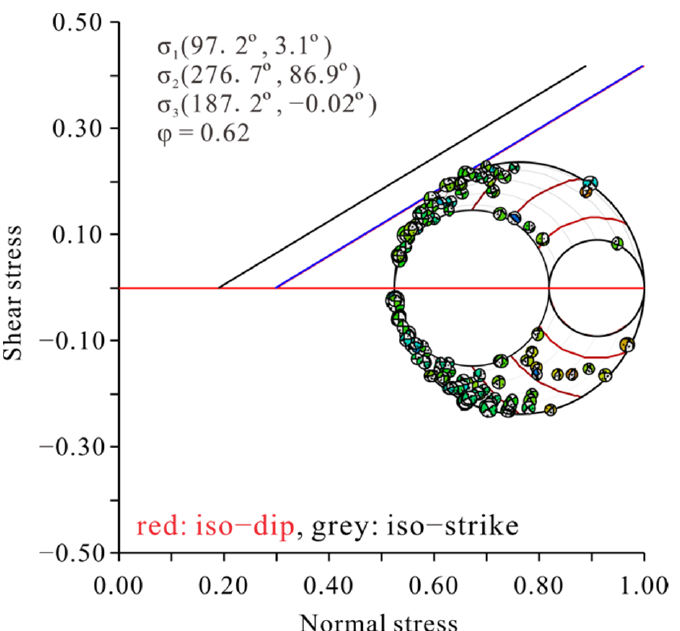
Figure 5. Mohr circle under normalized normal stress–shear stress coordinates. The colored spheres indicate the focal mechanism of selected earthquakes from this study. The blue line is the failure criterion when hydrostatic pressure is considered, and the black line is the failure criterion when the pore pressure is zero.